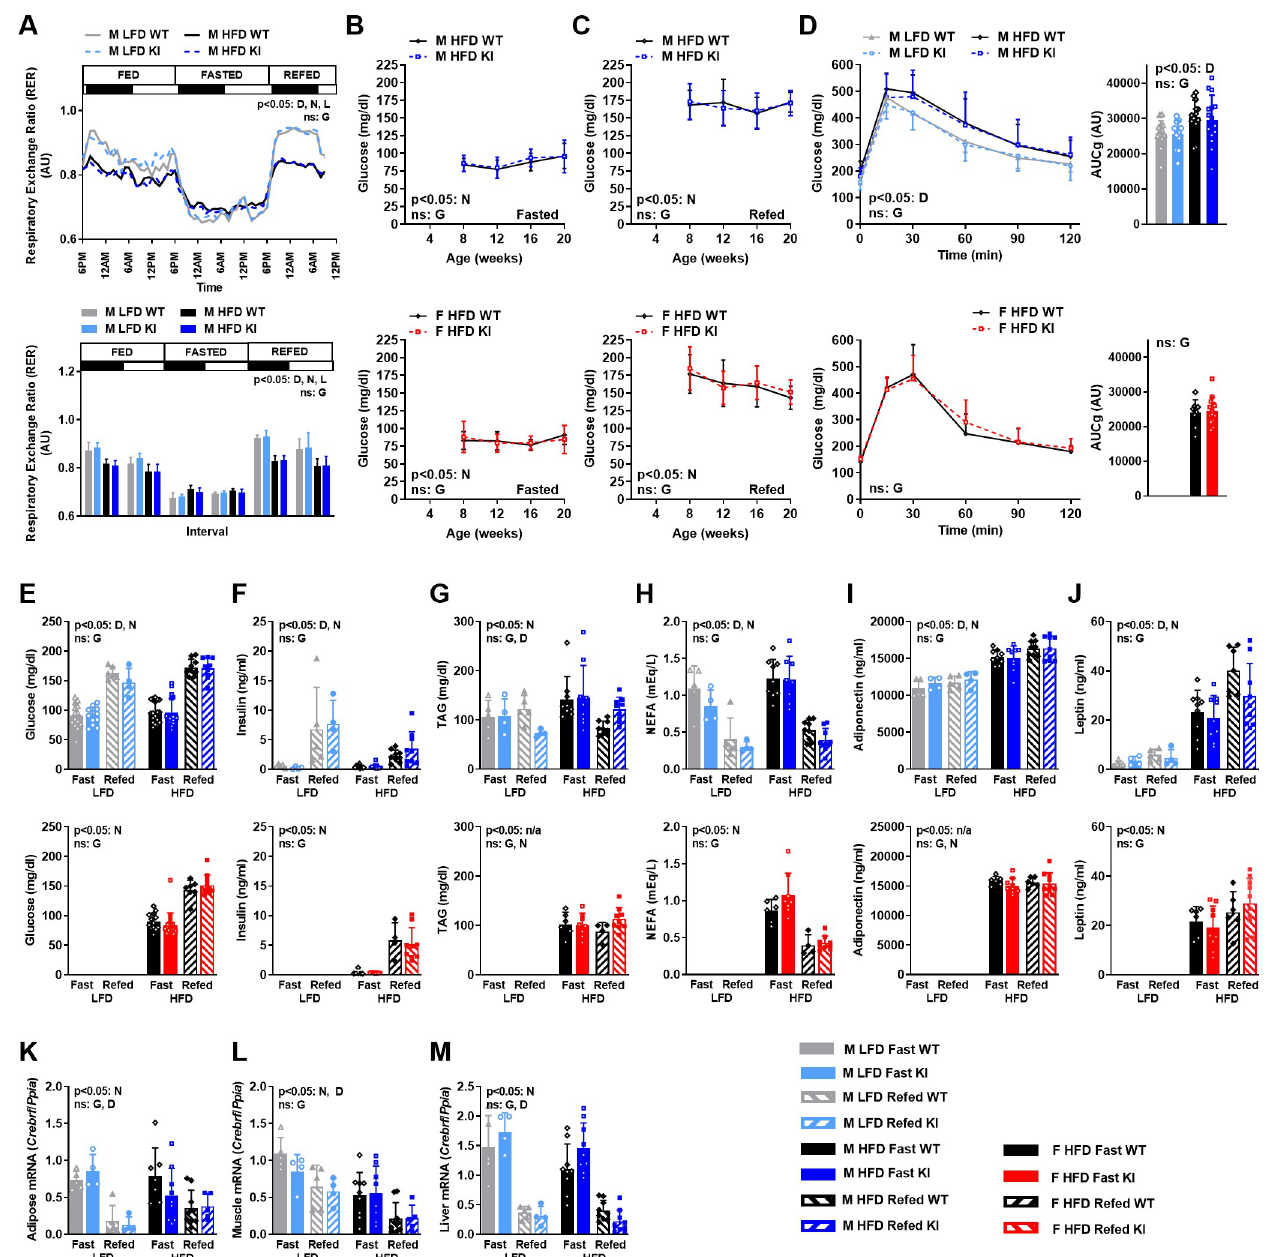
Fig 4. Effect of the CREBRF R458Q variant on energy substrate utilization, glucose homeostasis, and lipid homeostasis in response to acute ( < 24h fasting/refeeding) or chronic (high-fat diet) nutritional stress in mice. Respiratory exchange ratio (RER) in male (M, 12-week-old, n = 7-12/group) wild- type (WT) and knockin (KI) mice fed low-fat diet (LFD) or high-fat diet (HFD) during changes in nutritional status (fed, fasted, refed) over time using indirect calorimetry (Sable System). The protocol, parameters, and analyses are described in the legend for Fig 3 . (B-C) Blood glucose (dependent variable) at 4-week intervals from weaning until sacrifice in HFD-fed male (M, top, n = 18-19/group) and female (F, bottom, n = 14-20/group) wild-type (WT) and knockin (KI) mice in response to fasting ( B , 16h) and refeeding ( C , 16h fast followed by 12h refeeding). For clarity, B and C are shown as separate graphs but data are analyzed together. (D) Glucose tolerance tests (GTTs, left) and area under the curve for glucose (AUCg, right) in male (M, top, 19-week-old, n = 11- 16/group) and female (F, bottom, 19 -week-old, n = 9-14/group) wild-type (WT) and knockin (KI) mice. (E-J) Serum parameters in LFD- and HFD-fed male (E-J, top) and female (E-J, bottom) WT and KI mice sacrificed at 22-weeks-old in the fasted (16h) or refed (24h of fasting followed by 16h of refeeding) states (4-9/group): (E) glucose, (F) insulin, (G) triacylglycerol (TAG), (H) non-esterified fatty acids (NEFA), (I) adiponectin, and (J) leptin. (K-M) Expression of Crebrf relative to Ppia mRNA in adipose tissue (K) , gastrocnemius skeletal muscle (L) , and liver (M) in the same mice as (E-J). General linear models with (B-D) or without (E-M) time as a within subject variable were used to compare the above dependent variables between D = diet (LFD, HFD), N = nutritional status (fasted, refed), and G = genotype (WT, KI) as fixed factors. Data are mean (SD). Main effects with a significance level of p < 0.05 are indicated. Main effects with a significance level of � 0.05 are labeled as non-significant (ns).